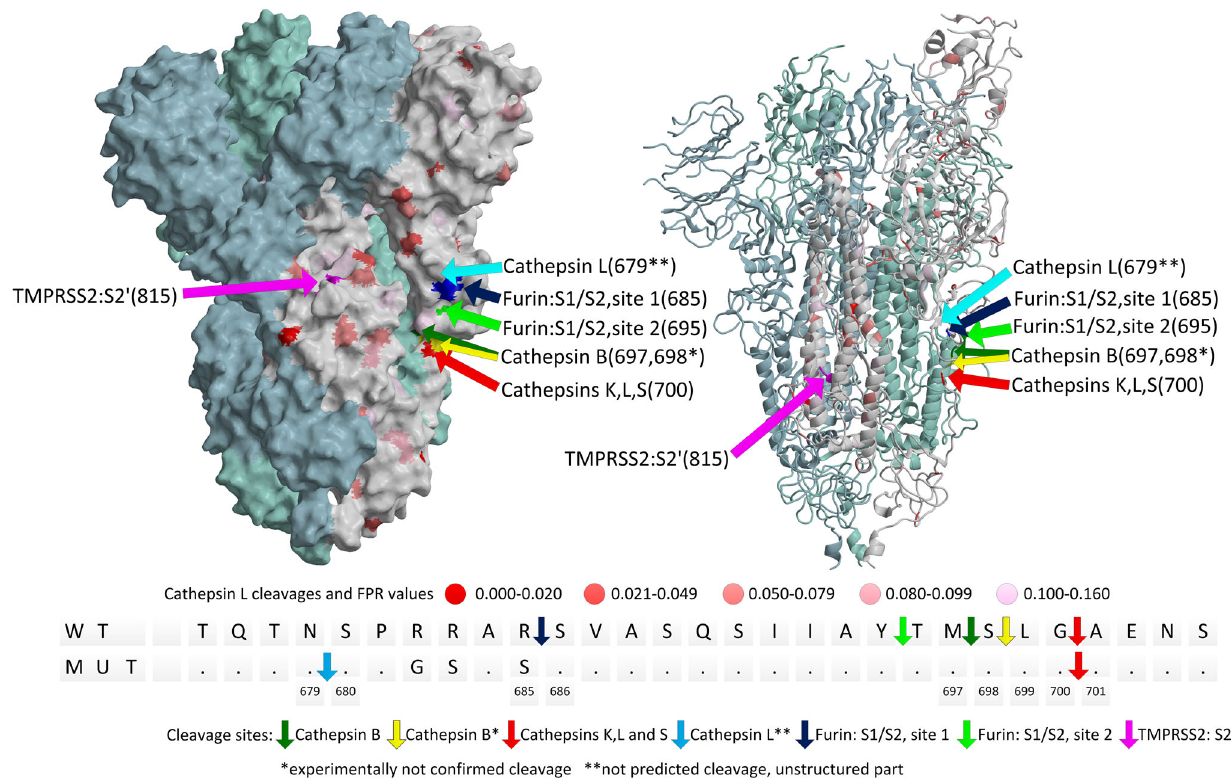
Fig. 4 Cleavages of SARS-CoV-2 wild-type (WT) and mutated furin cleavage site (MUT) S protein (6vsb, Wrapp et al. 2020 61 ). S protein is trimer, cleavages are presented in the single protomer colored white (chain A). Chain B and C are colored light blue and light green, respectively. The S protein was generated with MAIN 59 and rendered with RASTER 3D 66